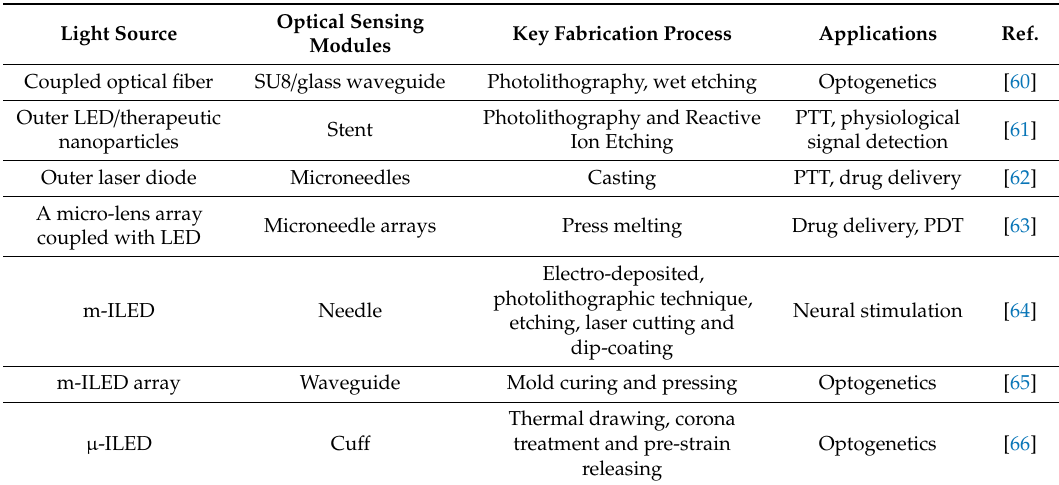
Table 3. Optical modules and fabrication process of integrated implantable optical